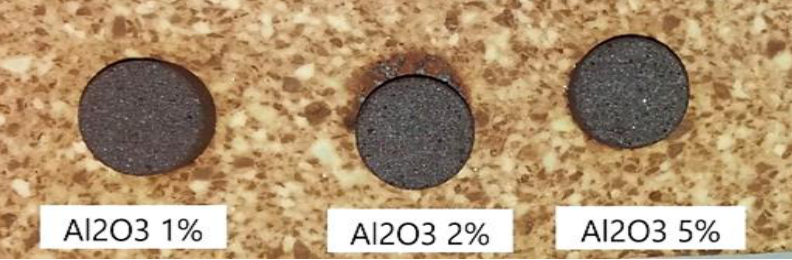
Mater. Proc. 2022 , 5 , 123 Figure 11. Peridotite sample E6743 with the Al 2 O 3 addition after calcination.